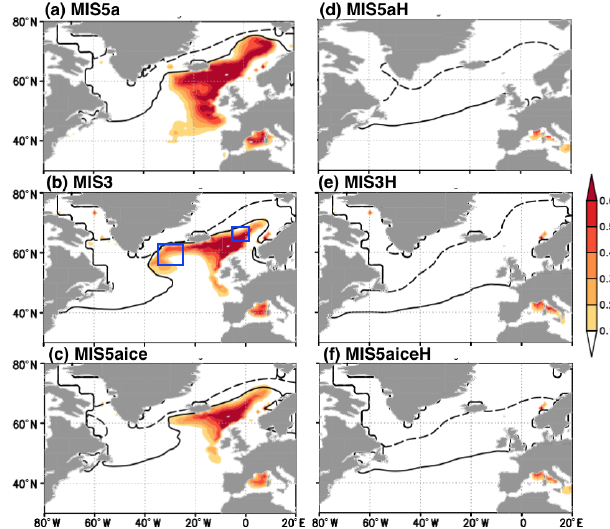
Figure 5. Sea ice edge (contour, 50% concentration) for Febru- ary (solid) and August (dashed) and deepwater formation region shown in annually averaged frequency of the convective adjust- ment at 300m depth (color). (a) MIS5a, (b) MIS3, (c) MIS3–5aice, (d) MIS5aH, (e) MIS3H, and (f) MIS3–5aiceH. In panels (a) – (c) , deepwater formation regions before the hosing are displayed, while in panels (d) – (f) , deepwater formation regions of the last 100 years of the hosing period are shown. In panel (b) , areas used for time series analysis in Figs. 8 and 12 are shown in blue